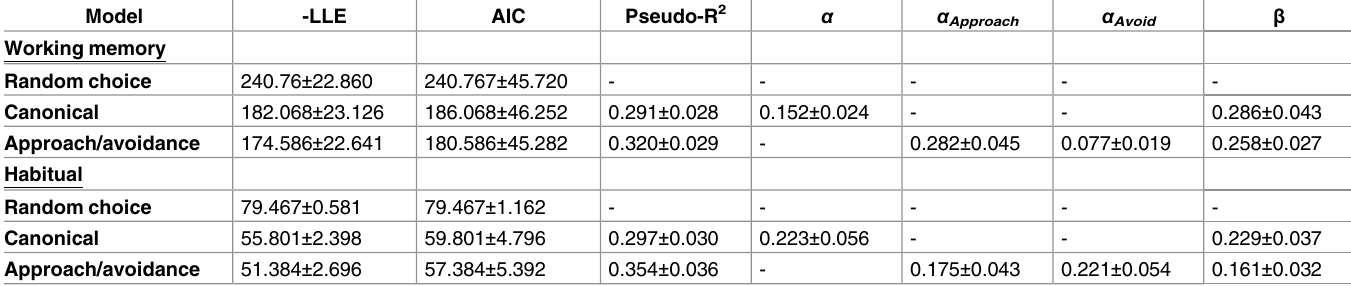
Table 2. As for the WM system, the approach/avoidance model provided the best fit to data, as revealed by significantly smaller AIC scores as compared to the canonical model [ t (33) =